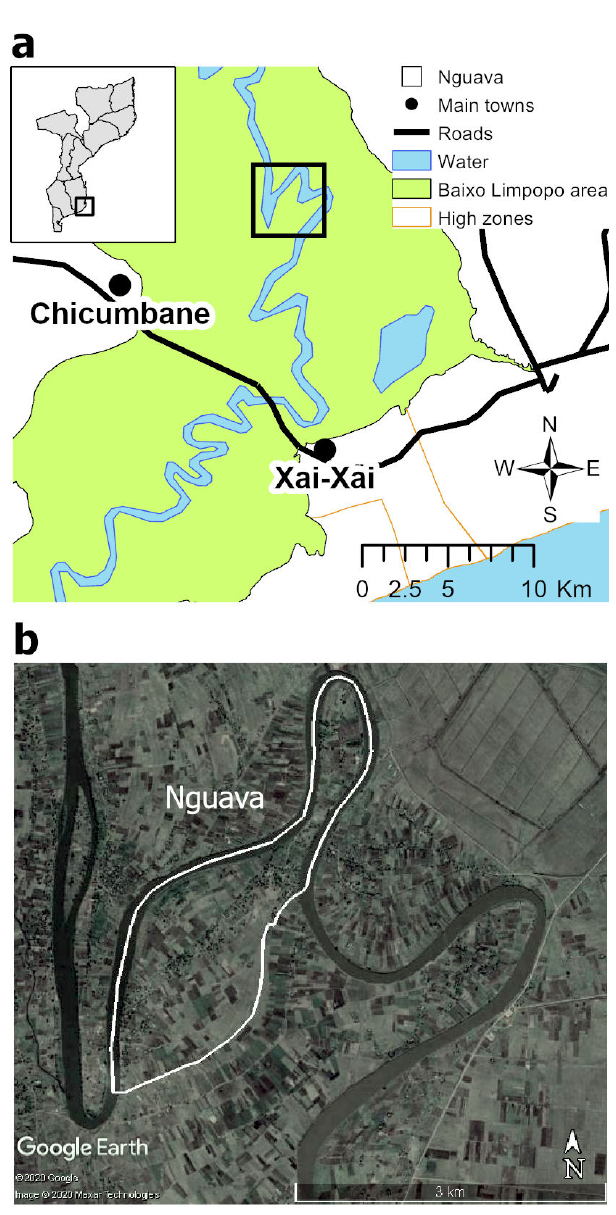
Fig. 1. Map of the study area. (A) Baixo (Lower) Limpopo Valley, with the study site, Nguava village, indicated by the black square. (B) Satellite image of Nguava